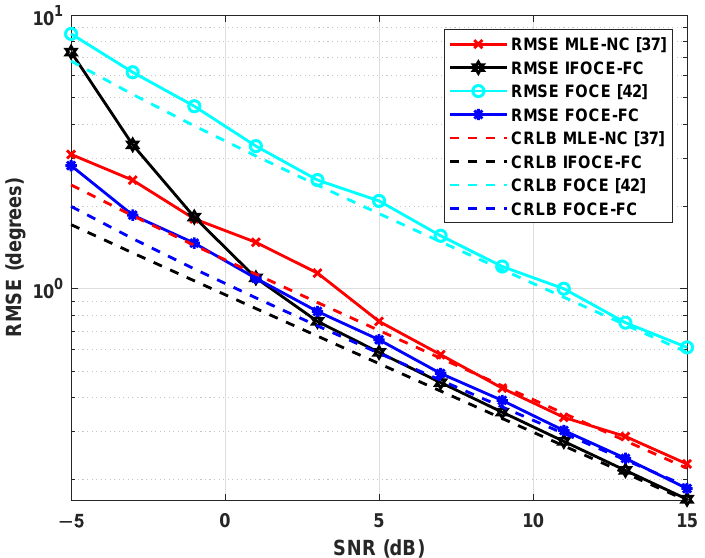
Figure 10. Comparison of different algorithms for the RMSE and corresponding CRLB versus the SNR under multiple signals and spatially colored noises in the ULA application.